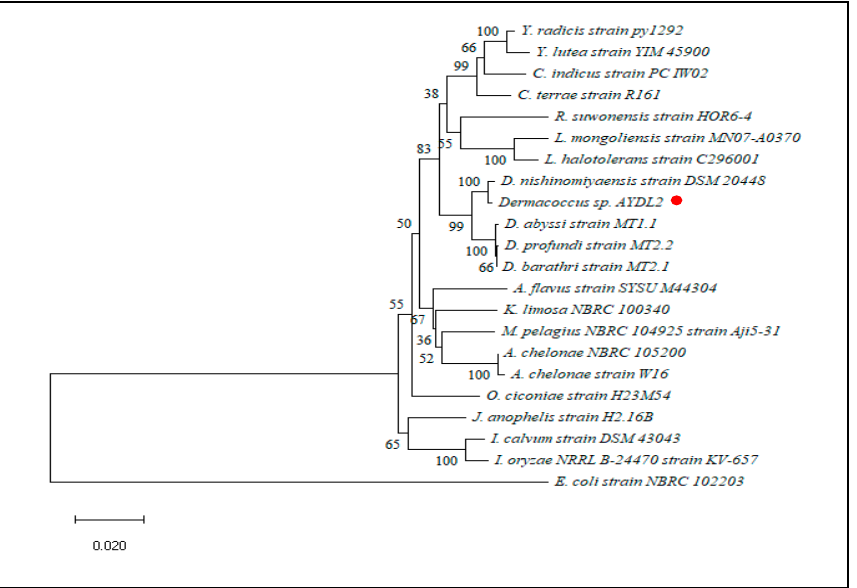
Figure 2. Phylogenetic tree of partial 16S rRNA gene sequences using the neighbour-joining method for AYDL1 ( ● ). (GenBank: OQ135211).